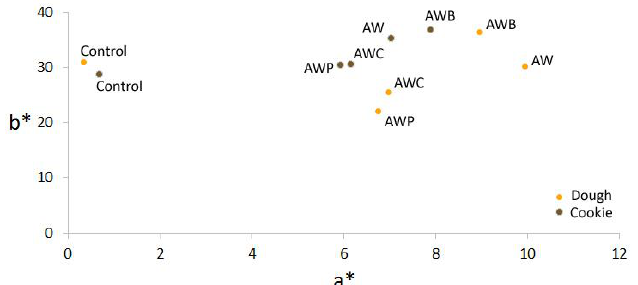
Figure 1. Color parameters of the dough and cookies elaborated with the different formulations. Values of the components a* (red–green) and b* (yellow–blue). Control—wheat flour (100%) and butter (100%); AWP—maize flour (50%), almond flour (33%), walnut flour (14%), poppy flour (3%), walnut oil (70%) and poppy oil (30%); AW—maize flour (60%), almond flour (28%), walnut flour (12%) and walnut oil (100%); AWC—maize flour (60%), almond flour (23%), walnut flour (12%), chia flour (5%), almond oil (50%) and walnut oil (50%); AWB—maize flour (82%), walnut flour (12%), almond flour (6%), butter (50%) and walnut oil (50%).